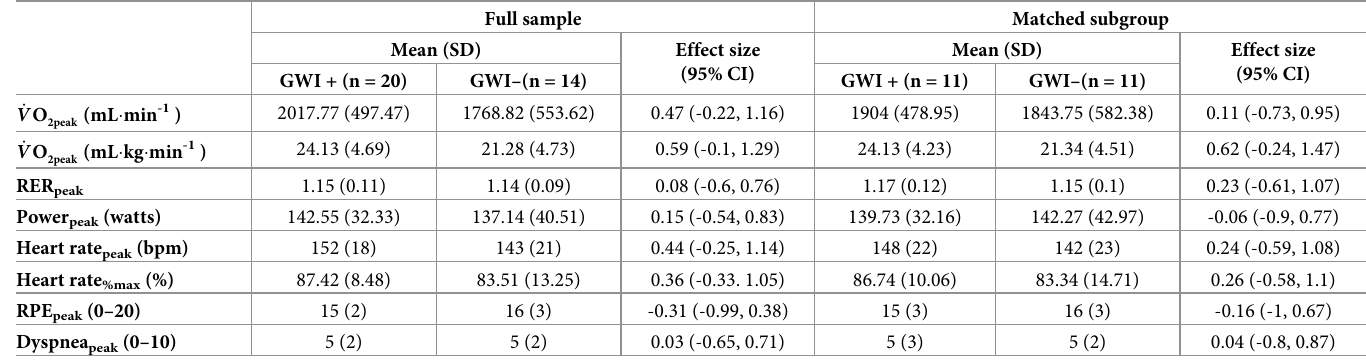
Table 3. Comparison of mean (SD) cardiopulmonary exercise data between participants with positive and negative Gulf War Illness diagnoses. Full